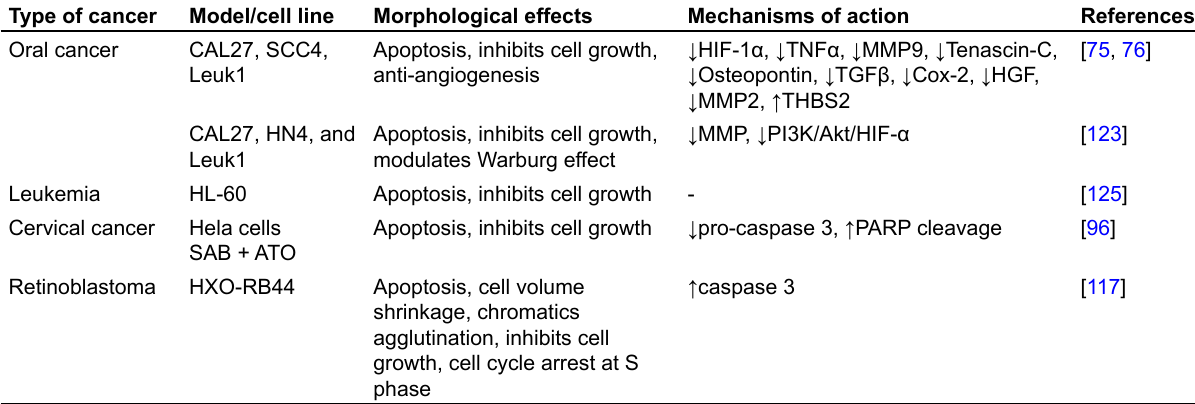
Table 1 . Selected anticancer effects of SAB on tumor cell lines Type of cancer